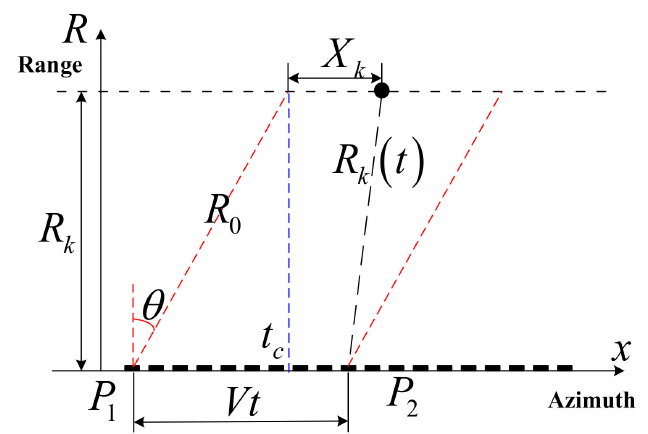
Figure 1. Spaceborne SAR schematic